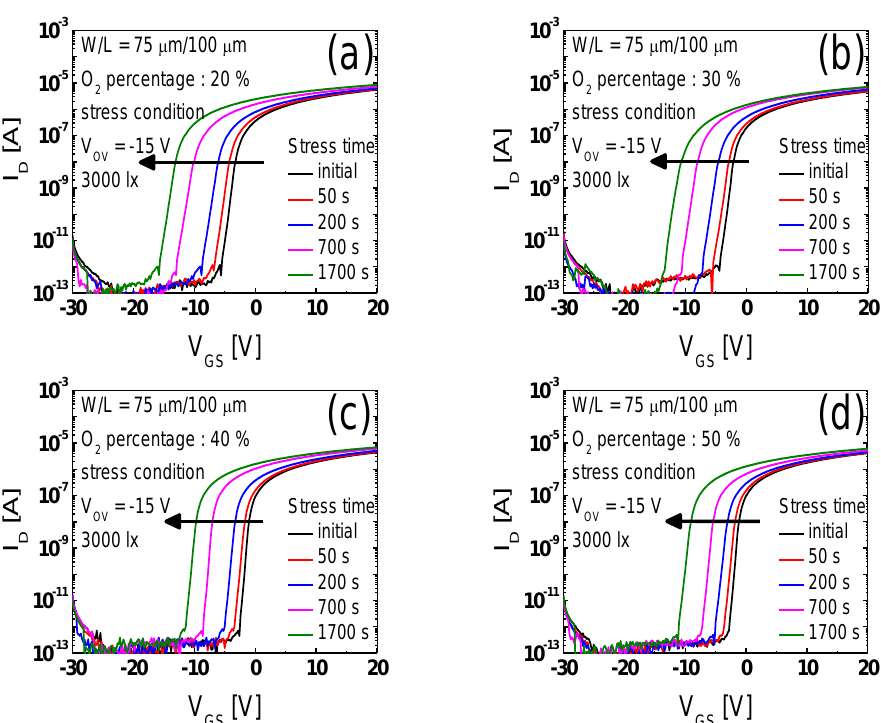
Figure 5. Time evolution of the transfer curves under constant V OV of −15 V with a light illumination (brightness = 3,000 lx) measured from the IGTO TFTs prepared at the oxygen contents of ( a ) 20%, ( b ) 30%, ( c ) 40%, and ( d ) 50% in the sputtering ambient.